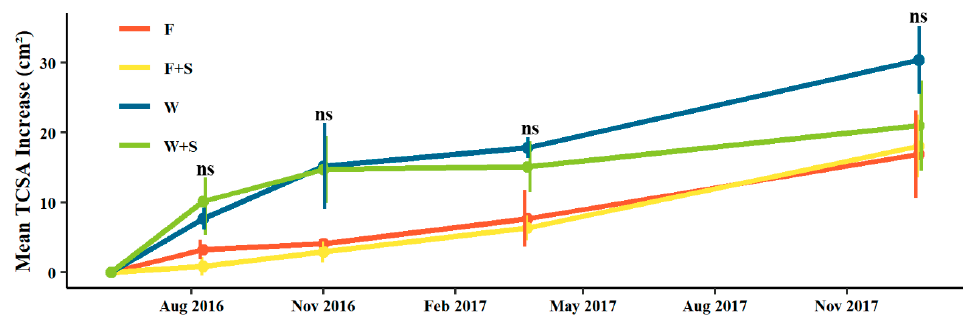
Figure 1. Mean increase in trunk cross-sectional area (TCSA, cm 2 ) of trees subjected to fall (F, red), fall and summer (F + S, yellow), winter (W, blue), or winter and summer (W + S, green). Points indicate mean ( n = 4 trees with exception of W + S where n = 3). Error bars indicate ± standard error. “ns” indicates no significance difference among means ( p > 0.05, Tukey HSD).